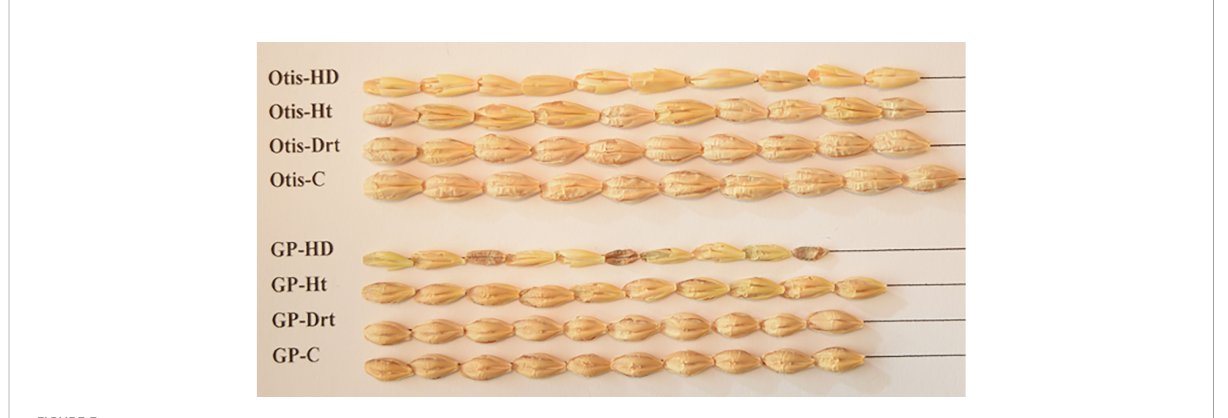
FIGURE 3 Seed physical characteristics of Golden Promise (GP) and Otis collected from plants subjected to heat (Ht), drought (Drt), combined heat and drought stress (HD) and control (C). Ten seeds randomly sampled from the seed bags were placed on a paper and arranged on a straight line and photographed using a Nikon camera.